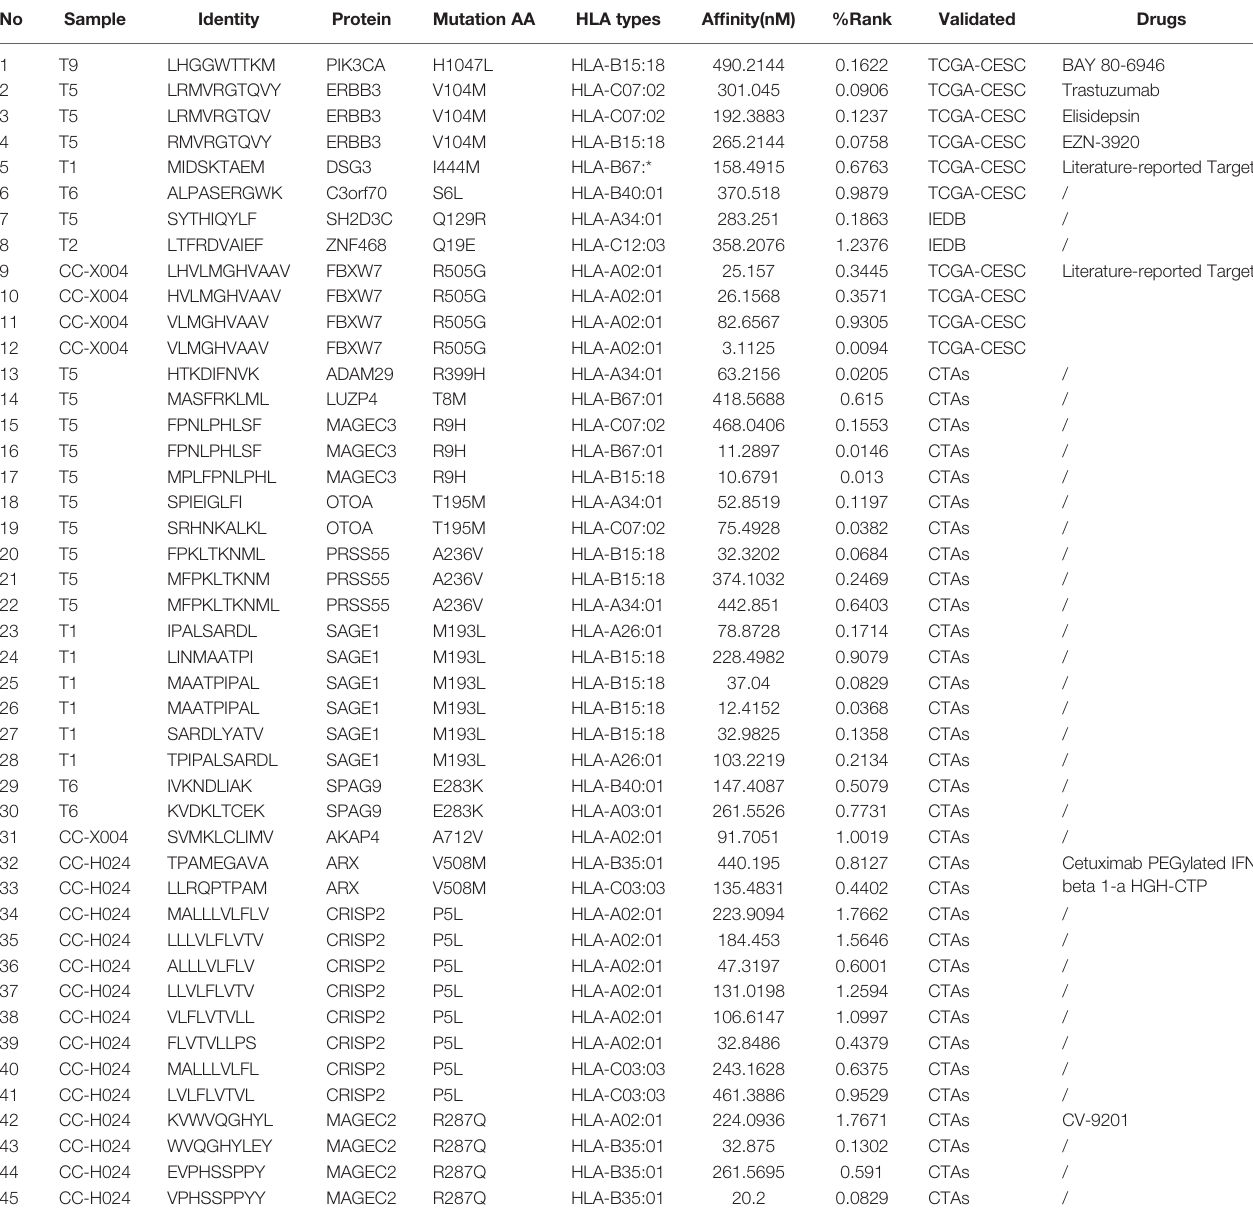
TABLE 3 | A list of candidate neoantigens validated by three public